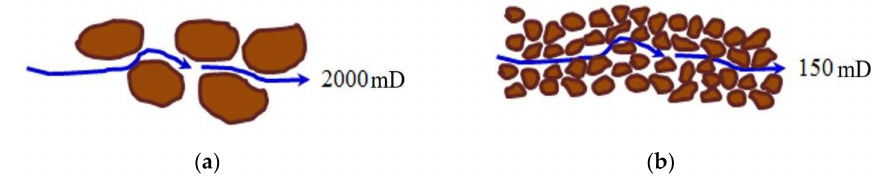
Figure 6. Effect of grain size and packing arrangement on permeability in porous media [44]. ( a ) Round large loosely-packed grains; ( b ) Irregular shaped small tightly-packed grains.